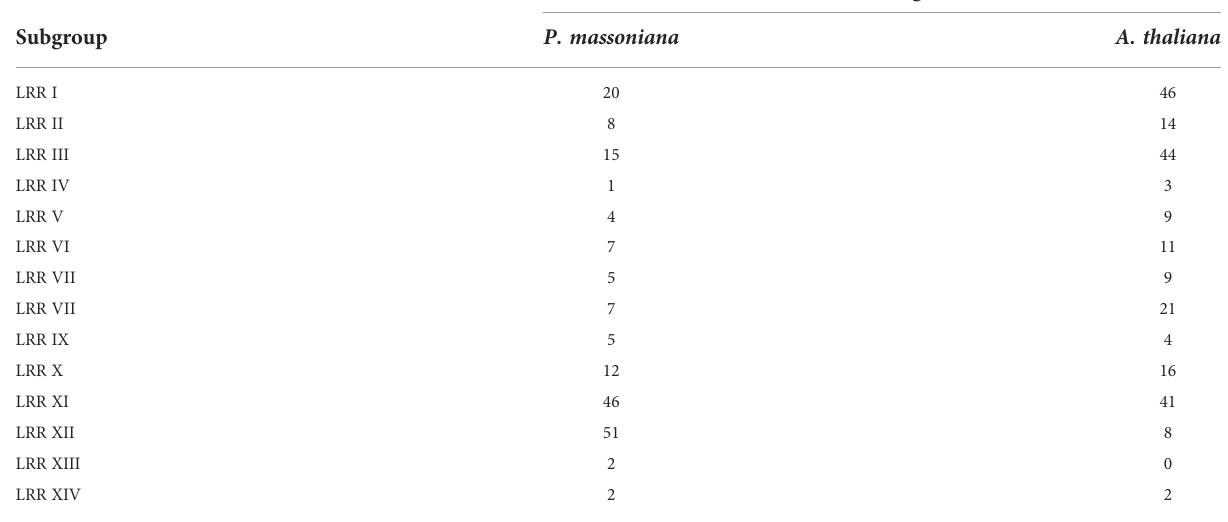
TABLE 1 Number of genes in the subgroups of LRR-RLK genes from Pinus massoniana and Arabidopsis thaliana.